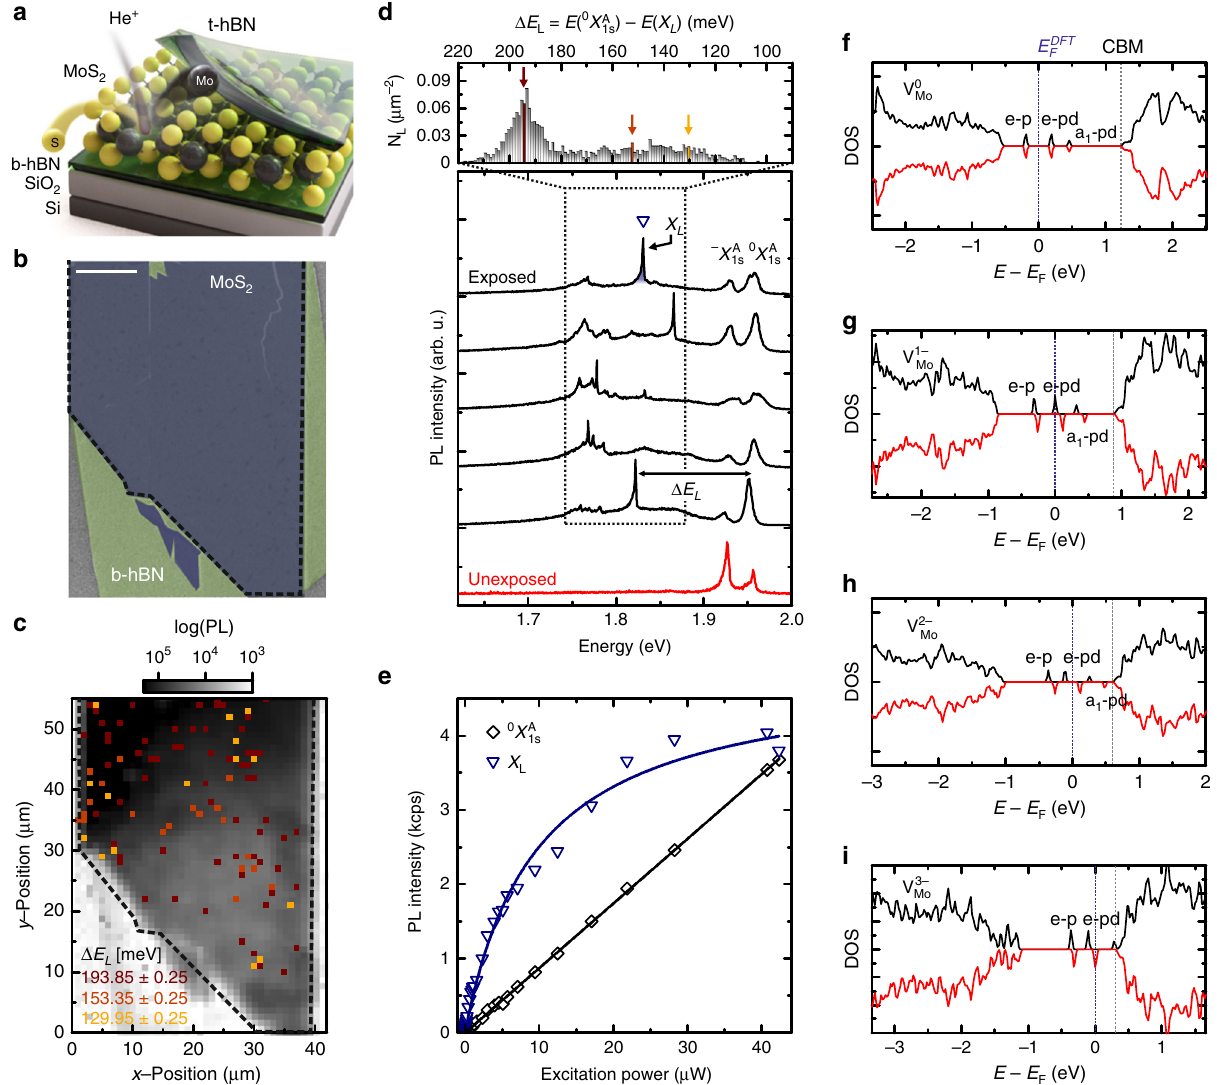
Fig. 1 Deterministically induced defect emitters in atomically thin MoS 2 realized by focused helium ions. a Schematic illustration of the exposed MoS 2 /hBN van der Waals heterostructure. b Helium ion microscopy image taken at a dose of σ = 2.2 ⋅ 10 12 cm − 2 . The scale bar is 10 μ m. c Spatially resolved and spectrally integrated photoluminescence mapping. The colored pixels depict the occurrence of emitters within 500 μ eV wide energy bins (highlighted by colored arrows in d ). d Bottom panel: typical low-temperature (10 K) μ -PL spectra of the exposed (black) and unexposed (red) hBN/MoS 2 /hBN heterostructure. The spectra of exposed MoS 2 feature emission from mobile excitons 0 X A and trions (cid:1) X A , as well as single emission lines X L (open 1 s 1 s triangle) at lower energies. Top panel: a histogram of the emission energies detuned by Δ E L = E ( 0 X A ) − E ( X L ) below 0 X A . e Power dependence: 0 X A 1 s 1 s 1 s shows an expected linear power dependence, while the X L emission saturates for higher excitation powers (data for the emitter highlighted by open triangle in d ). f – i DFT calculated spin-up (black) and spin-down (red) density of states (DOS) of the neutral V 0 Mo , single negatively V 1 (cid:1) Mo , double negatively V 2 (cid:1) Mo , and triple negatively charged V 3 (cid:1) Mo molybdenum vacancy. The DOS of V 0 Mo shows doublet e - p , e - pd and singlet a 1 - pd defect states inside the band gap. The a 1 - p singlet state is situated within the valence band. The more electrons are added to the vacancy the closer the defect states and the DFT computed Fermi shift to the conduction band minimum (CBM) because of the on-site Coulomb